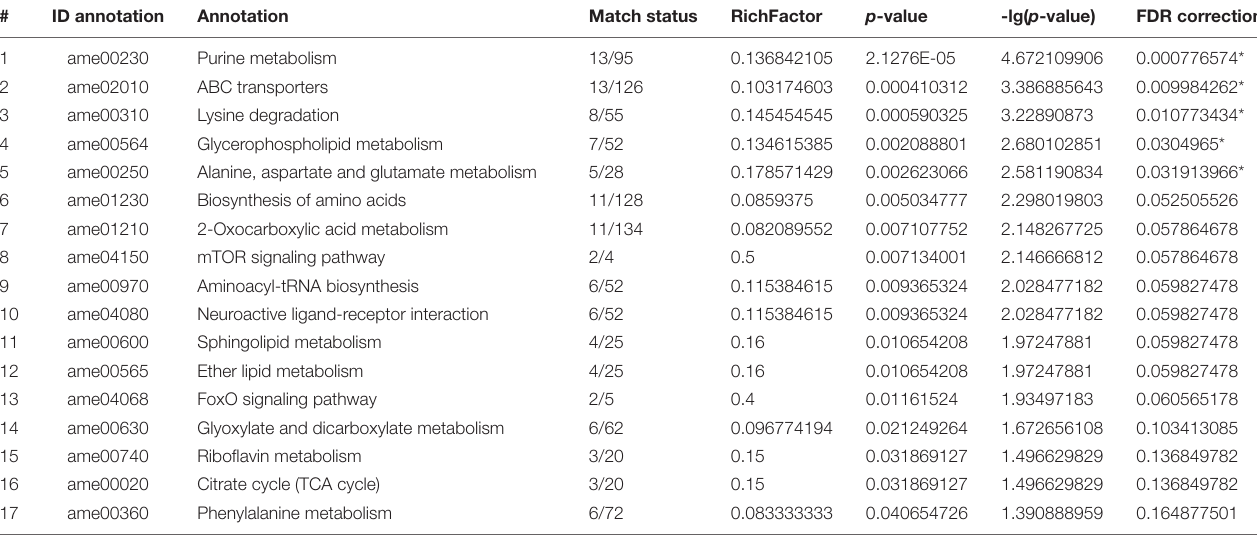
FIGURE 7 | Pathway enrichment analysis of the differentially expressed metabolites in the comparison of NLQS with VQS in the honeybee Apis mellifera . (A) Pathway impact analysis using the joint pathway analysis module (Chong et al., 2019). The color from white to red represents the larger p -value, and the size of each node corresponds to its pathway impact value from the pathway topology analysis, respectively. (B) Heat map analysis of the metabolic pathways enriched by the differentially expressed metabolites. The analysis was based on a visualization analysis of metabolic pathways (Xia and Wishart, 2010) originated from KEGG http://www.kegg.jp/. From green to red indicates increasing p- values; the point size indicates the number of metabolites enriched in each pathway. TABLE 2 | Metabolic pathway enrichment analysis based on p -value no more than